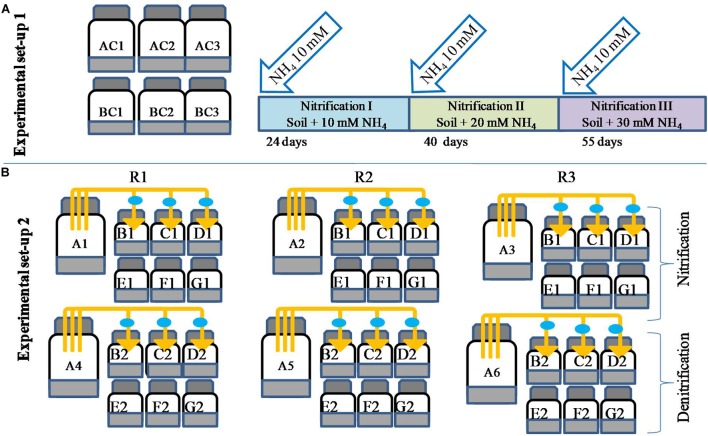
Microcosm design for biosynthesis of biogenic nitrate and estimation of nitrification potential of soil under repeated NH4–N amendment (setup 1, A). Microcosm setup to evaluate the effect of microbial volatiles (mVOCs) on nitrification and denitrification (setup 2, B). Bottles of 250 ml volume contained 50 g soil and were un-amended (AC1–AC3) or amended with 10 mM NH4 (BC1–BC3). After complete nitrification of 10 mM NH4 (24 days) a second dose of NH4 was added (BC bottles) and after complete nitrification (40 days) a third dose of 10 mM NH4 was added (BC bottles). The third nitrification stage was completed in 55 days of incubation. The three complete nitrification phases were designated as nitrification I, nitrification II, and nitrification III. The second setup (B) was designed to evaluate the effect of mVOCs (A1–A6) on nitrification and denitrification. All experimental treatments included three replicates (R1, R2, R3). The six source bottles (A1–A6) were connected to 18 sink bottles (130 ml volume containing 20 g of soil), shown as B1, C1, D1, B2, C2, and D2. The control bottles (130 ml bottle containing 20 g soil) were without exposure to mVOCs (E1, F1, G1 and E2, F2, G2). The connectors fitted with 0.2-μm filters (filled circle) were used to connect source and sink bottles. After each nitrification stage, one sink bottle and one control bottle were further incubated to determine nitrification and denitrification rates as mentioned the methodology.